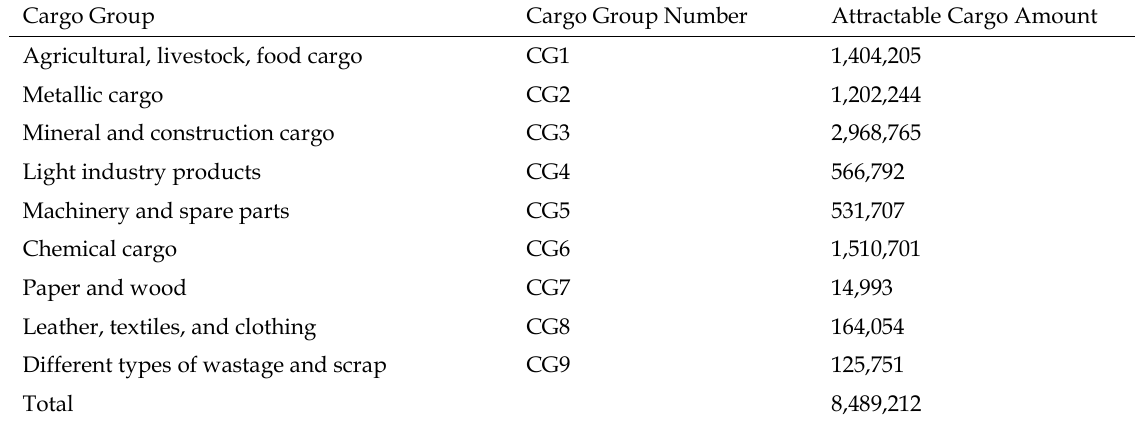
Prediction of attractable cargo amount to the extended gate in each cargo class Cargo Group Number Attractable Cargo